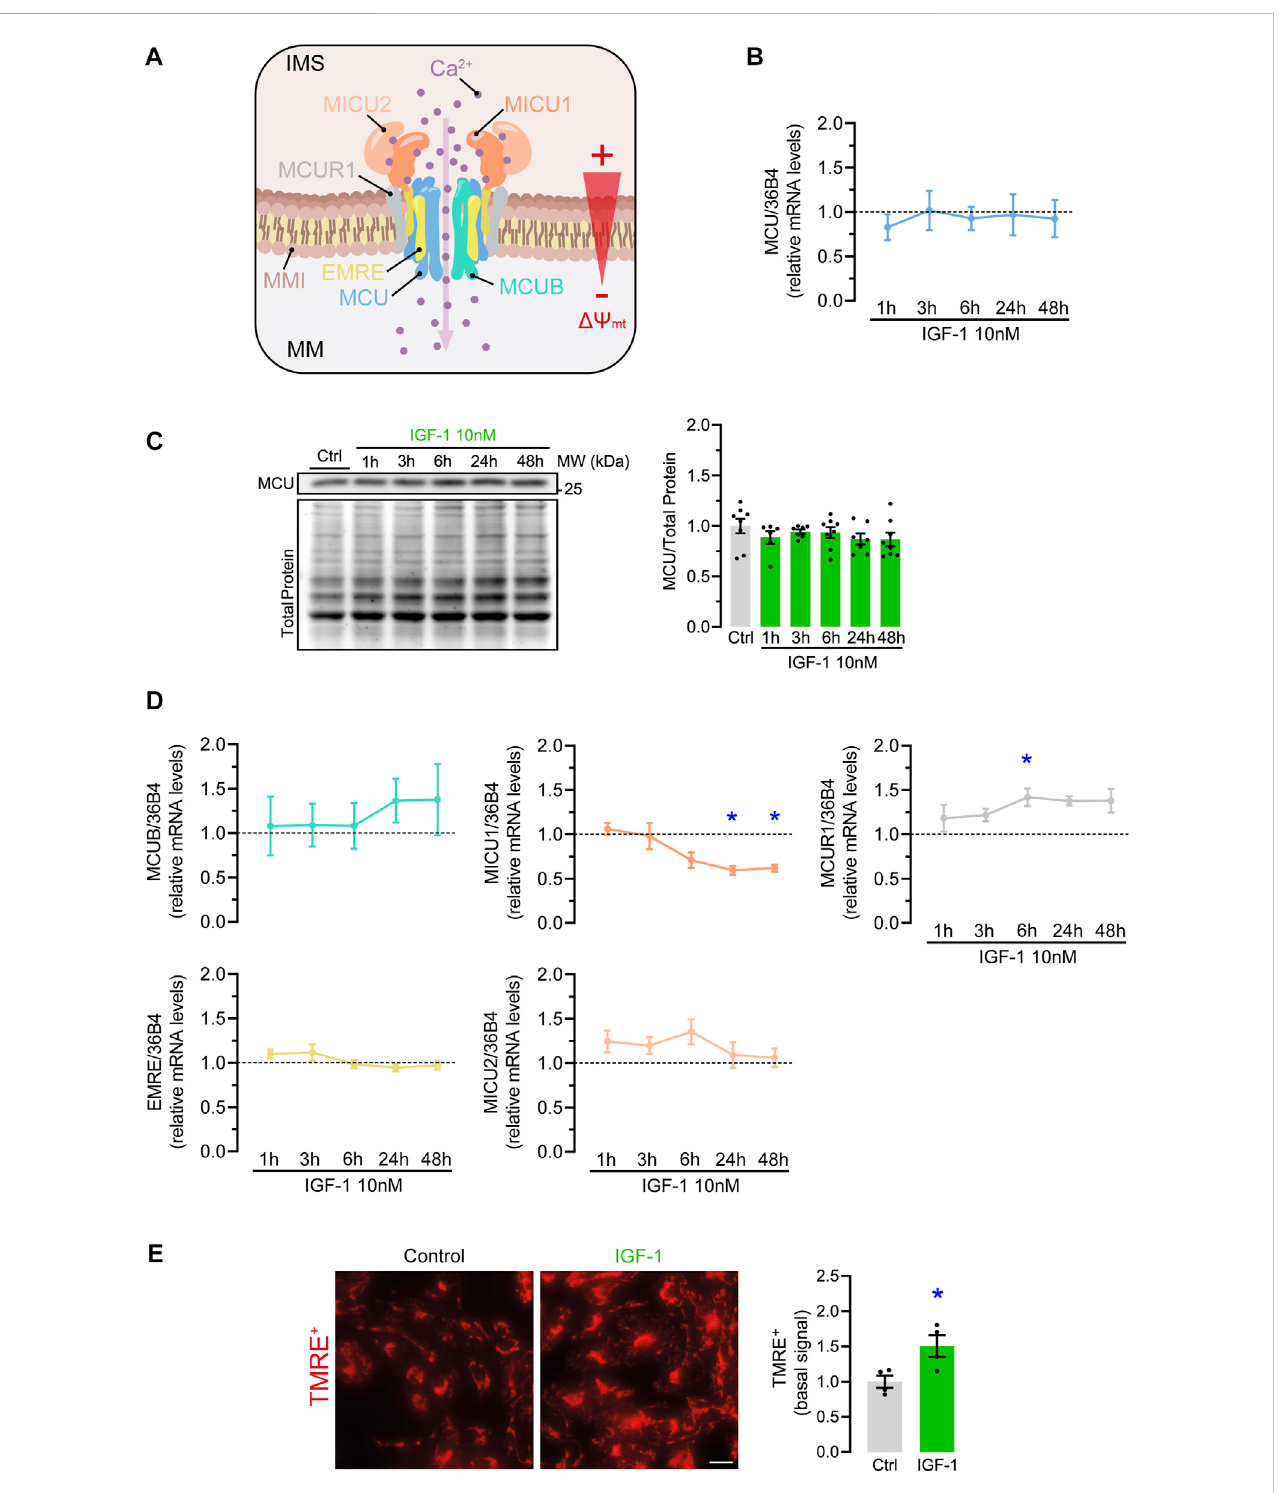
FIGURE 2 Effect of IGF-1 on MCU complex elements expression and Δ Ψ mt in hES-CMs. (A) Scheme of MCU complex components (MCU, MCUB, SMDT1, MICU1, MICU2, MCUR1) inserted in the inner mitochondrial membrane (IMM) and a representation of the Δ Ψ mt between the intermembrane space (IMS) and the mitochondrialmatrix (MM); (B) Relative mRNA and (C) protein levelsof MCU inhES-CMs stimulated with IGF-1for 1 – 48 h( n =6 — 8); (D) RelativemRNA levels of MCU complex regulatory subunits (MCUB, SMDT1, MICU1, MICU2, MCUR1) in hES-CMs stimulated with IGF-1 for 1 – 48 h ( n = 6 — 8). The dotted line represents the mRNA levels of the untreated (control) condition; (E) Relative levels of basal TMRE + in cells treated with IGF-1 for 24 h * p < 0.05 vs. control. Scale bar: 10